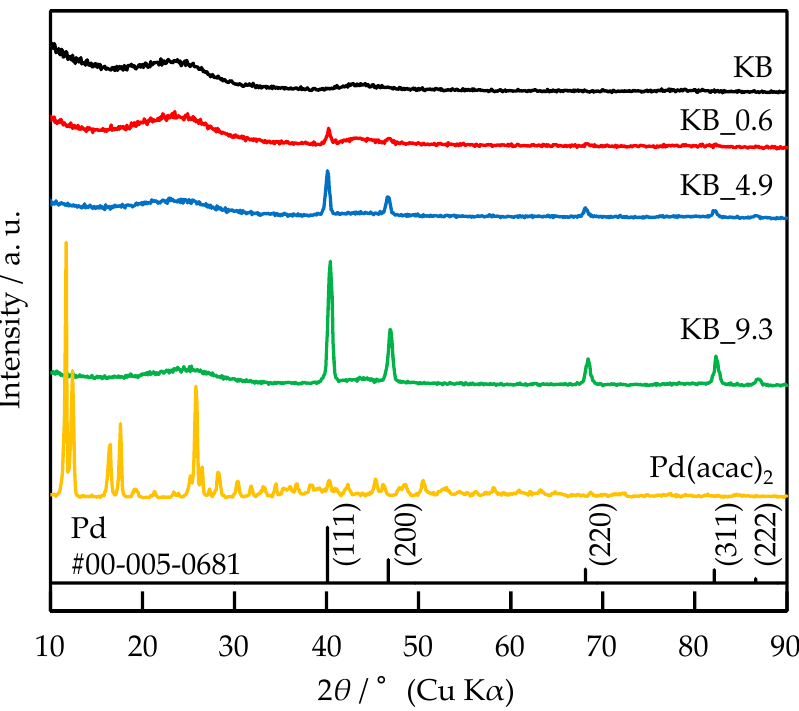
Figure 4. Cu K α XRD patterns of KB, KB_0.6, KB_4.9, KB_9.3, and Pd(acac) 2 . JCPDS data of Pd (#00-005-0681) is included at the bottom.